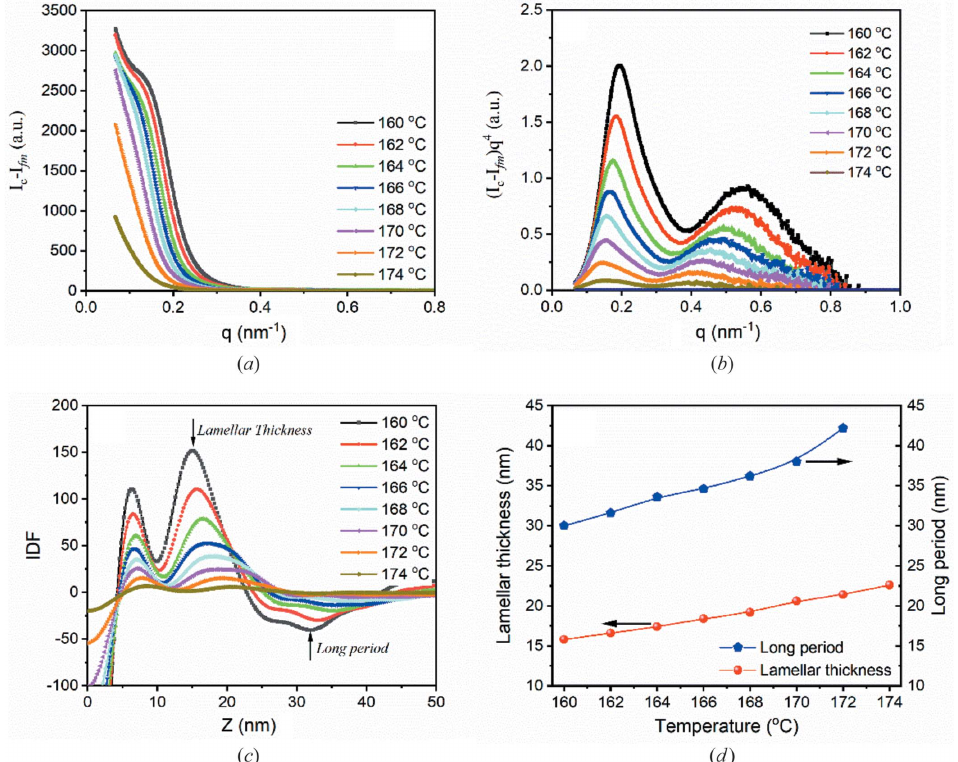
Figure 4 ( a ) Scattering profiles after subtracting the scattering at 220 (cid:3) C. ( b ) ( I c (cid:5) I fm ) q 4 and ( c ) IDFs in the range of 160–174 (cid:3) C. ( d ) Long periods and lamellar thicknesses obtained from ( c